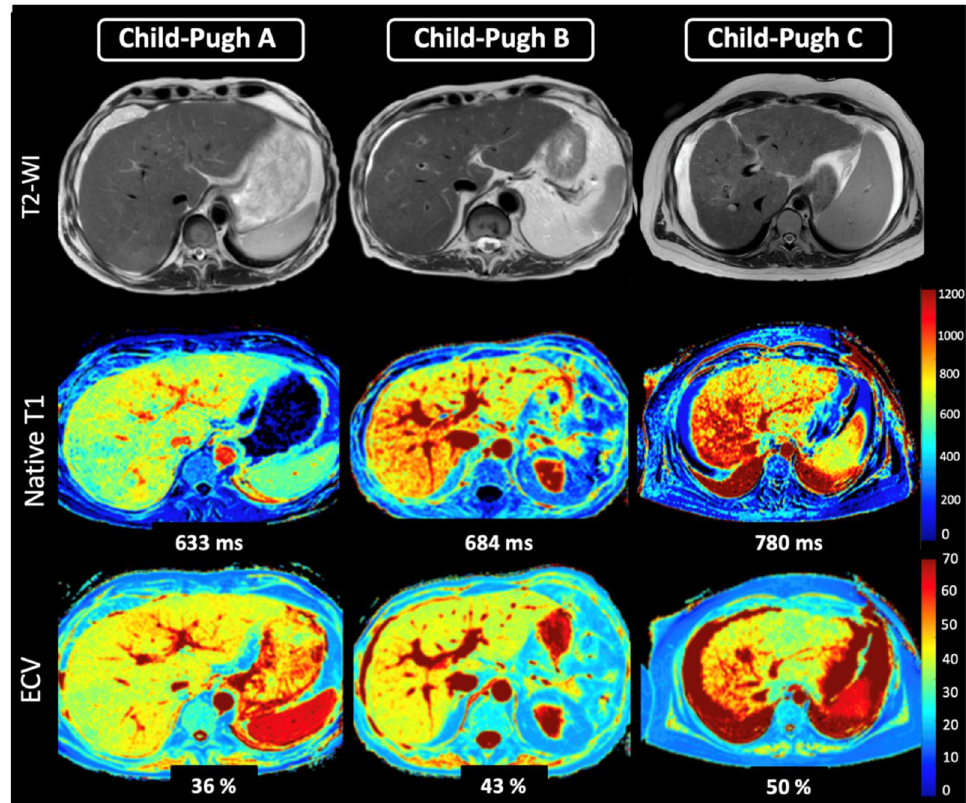
Figure 1. Representative images of T2-weighted images, hepatic native T1 and extracellular volume fraction (ECV) maps from a 54-years-old male patient with liver cirrhosis Child–Pugh class A, from a 61-year-old female patient with Child–Pugh class B, and a 41-year-old female patient with Child–Pugh class C. T1 relaxation times and ECV show increased values depending on Child–Pugh class. T2-WI T2-weighted image, ECV extracellular volume